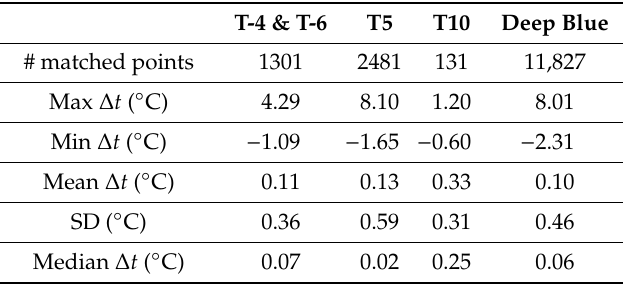
Table 2. ∆ t ( XBT-Argo) for each XBT type involved. Depth: 0 m-bottom ( ± 7 days).